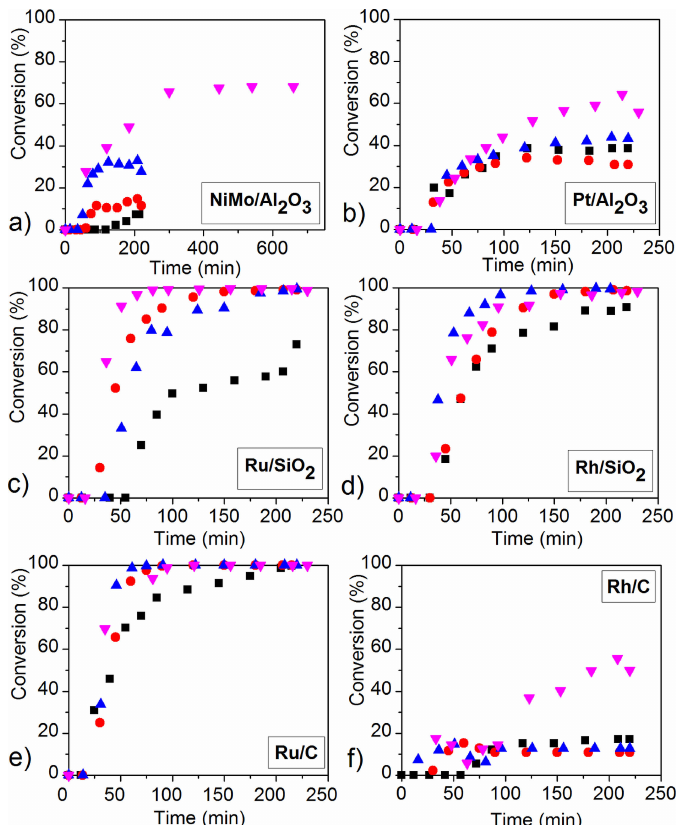
Figure 5. Summarized conversion of mucic acid and its lactone over ( a ) NiMo/Al 2 O 3 , ( b ) Pt/Al 2 O 3 , ( c ) Ru/SiO 2 , ( d ) Rh/SiO 2 , ( e ) Ru/C, and ( f ) Rh/C at (cid:4) T = 125 ◦ C, • T = 135 ◦ C, (cid:78) T = 150 ◦ C, and (cid:72) T = 175 ◦